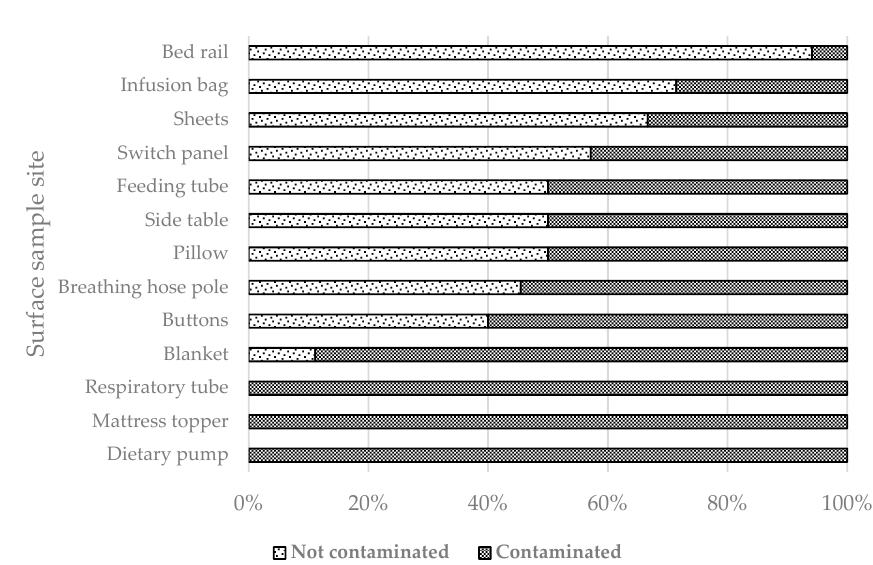
Figure 2. Percentage of environmental bacteria resistant to penicillin G, erythromycin, clindamycin, and tetracycline, found in the surroundings of each patient. 0%